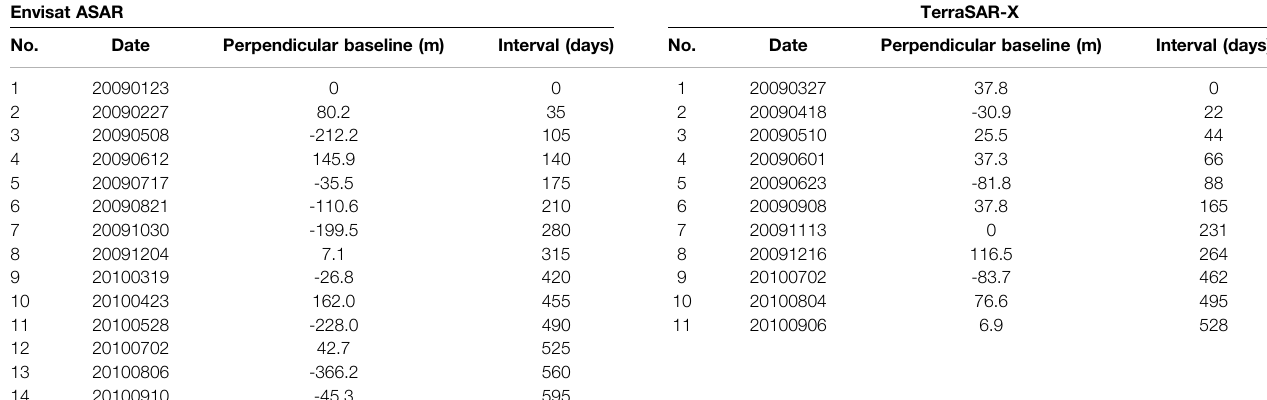
TABLE 1 | Envisat ASAR and TerraSAR-X